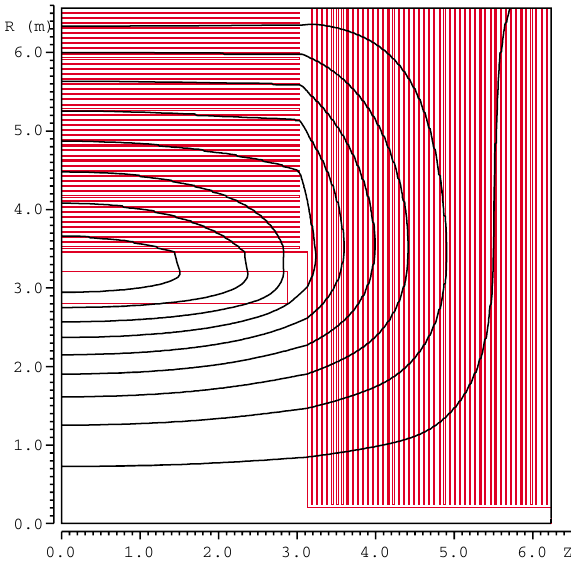
FIG. 3. (Color) The model of the silicon detector (SiD) with field lines calculated by ANSYS